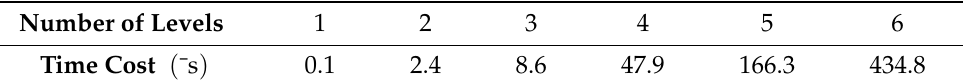
Table 6. Computer time on a personal computer required for hierarchical refinement of the geometry shown in Figure 19.